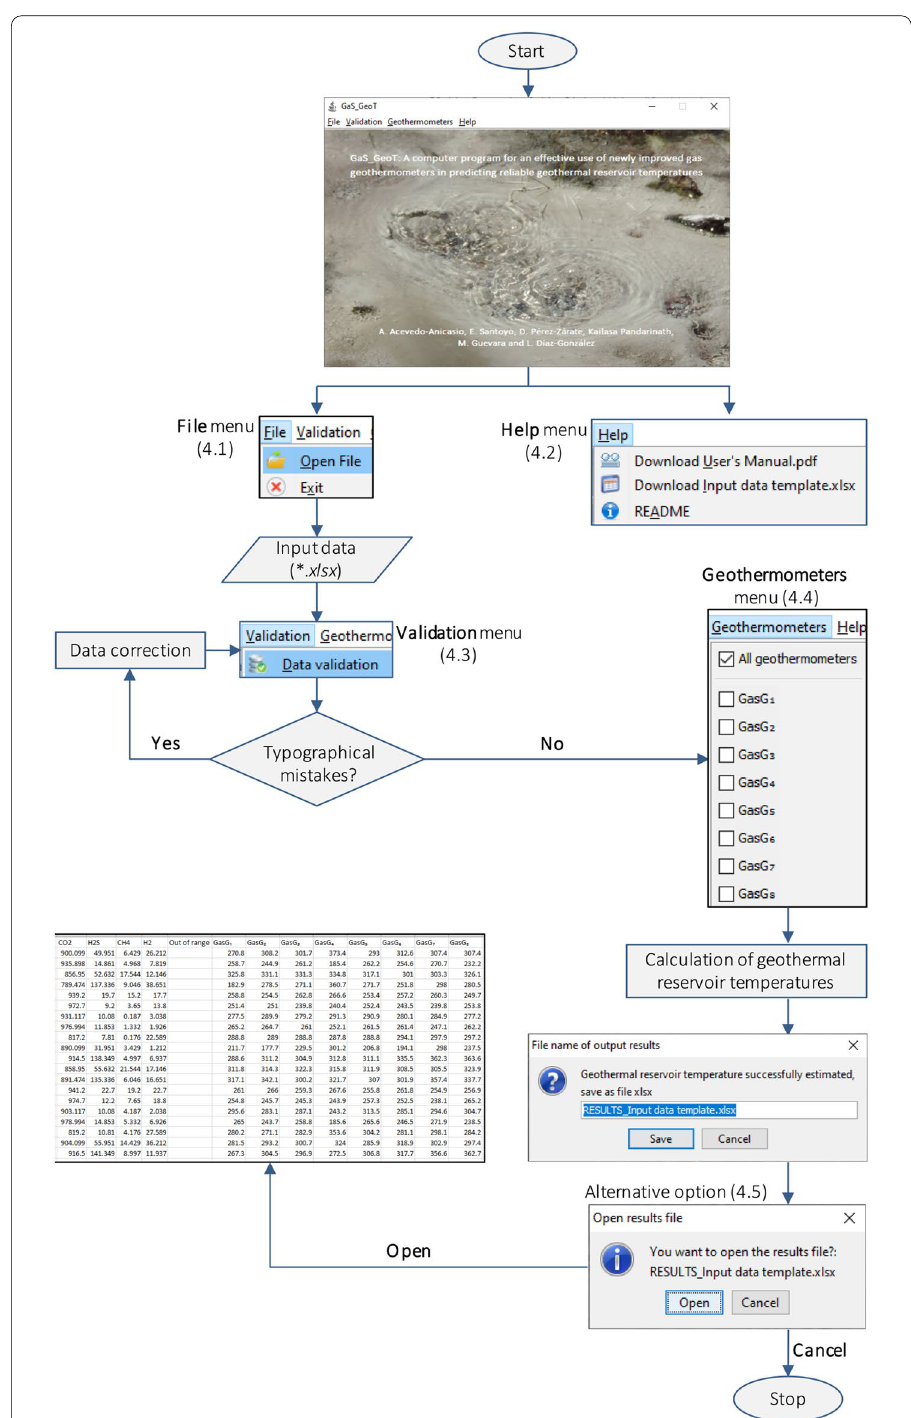
Fig. 4 Schematic flow diagram and menu screens that show the execution of the computer program GaS_ GeoT for the estimation of geothermal reservoir